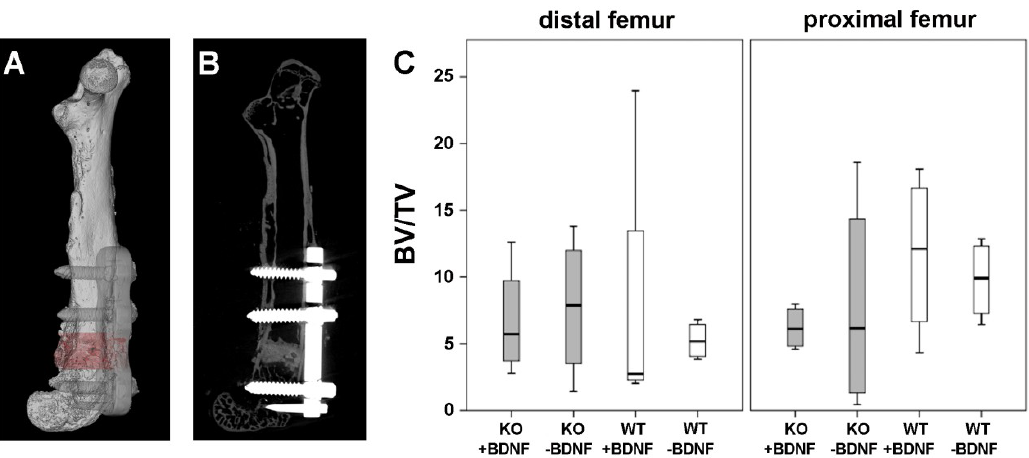
Figure 2. Micro-CT: ( A ) 3D volume rendering of a M3 mAChR KO mouse femur with attached metaphyseal locking plate. Marked in red is the bone cement/MBG composite, ( B ) cross sectional image of the same femur with attached metaphyseal locking plate shown in white ( C ) analysis of BV/TV in M3 mAChR KO and WT mice.